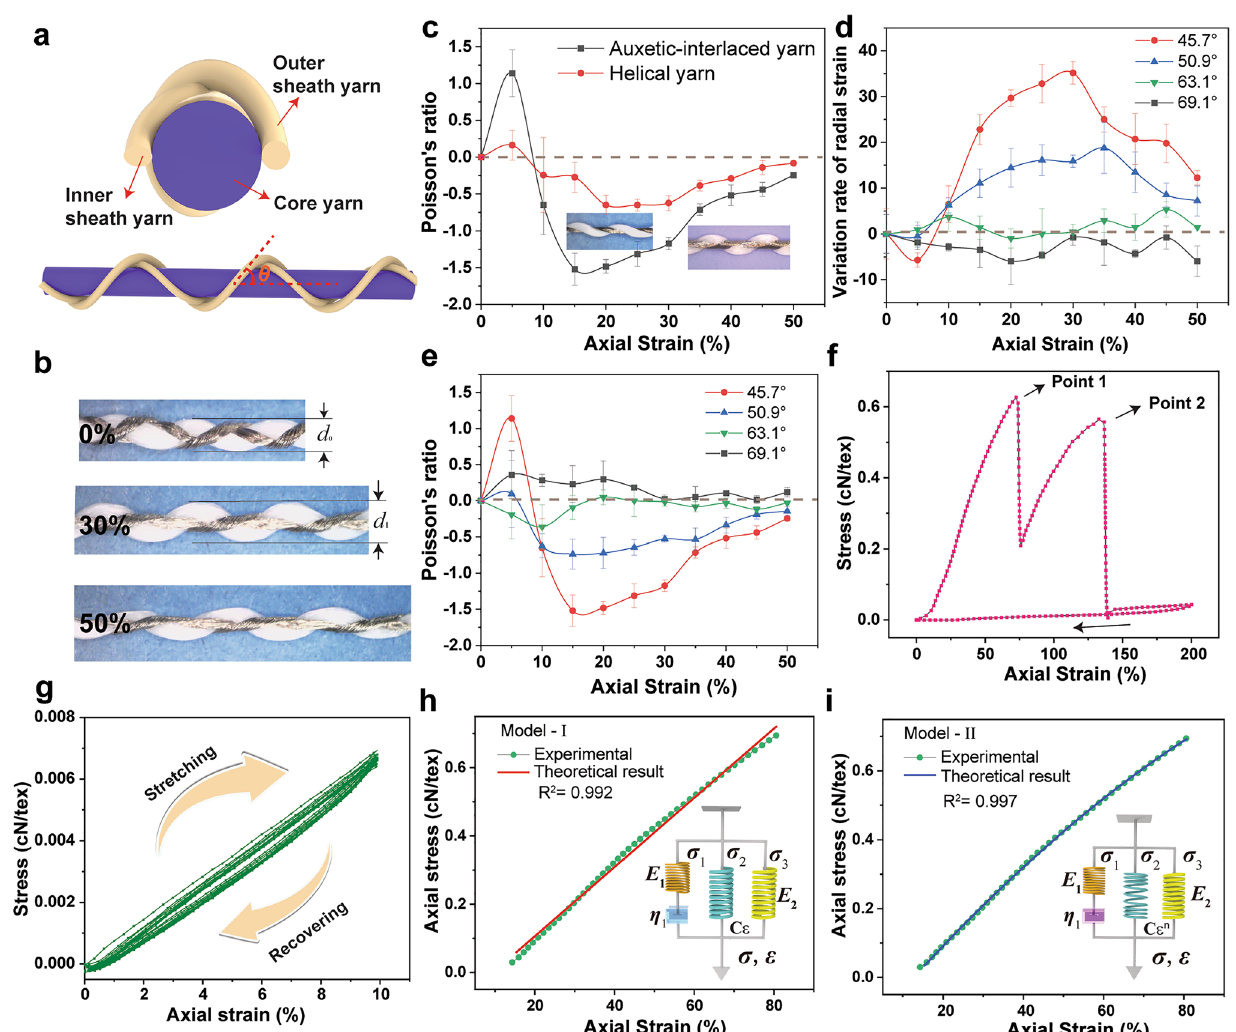
Fig. 2 Geometric and mechanical behavior of an AIYS sensing unit. a Cross-sectional and side view of the AIYS. b AIYS being stretched to 0%, 30%, and 50% elongation, showing negative Poisson’s ratio behavior. c Comparison of the Poisson’s ratios between interlaced-helical and single-helical auxetic yarn. “Axial strain” means the stretching strain applied along the axial direction of AIYS composite yarn. d Variation of the radial strains of AIYS with different wrapping angles of 45.7°, 50.9°, 63.1°, 69.1°. “Radial strain” means the deformation strain measured along the radial direction of AIYS composite yarn. e Poisson’s ratios of the AIYS with different wrapping angles. f Typical mechanical behavior of the AIYS during stretching and recovery from 0 to 200% elongation. g Cyclic mechanical stretching performance of the AIYS during 0–10% elongation. h Comparison of experimental and theoretical viscoelastic mechanical behavior of an AIYS described by Model-I and